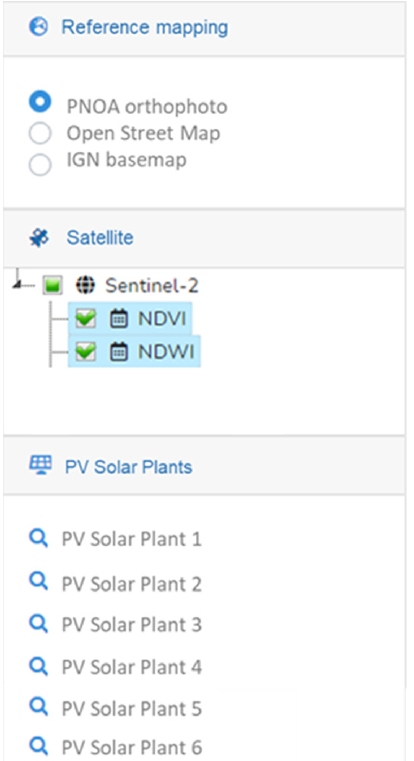
Figure 3. Geospatial information manager in detail.